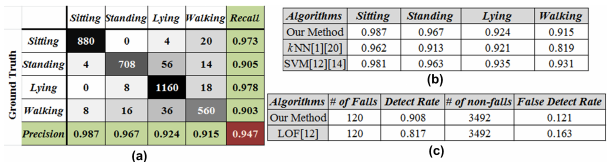
Figure 13: Confusion Matrix and Detection Perfor- mance